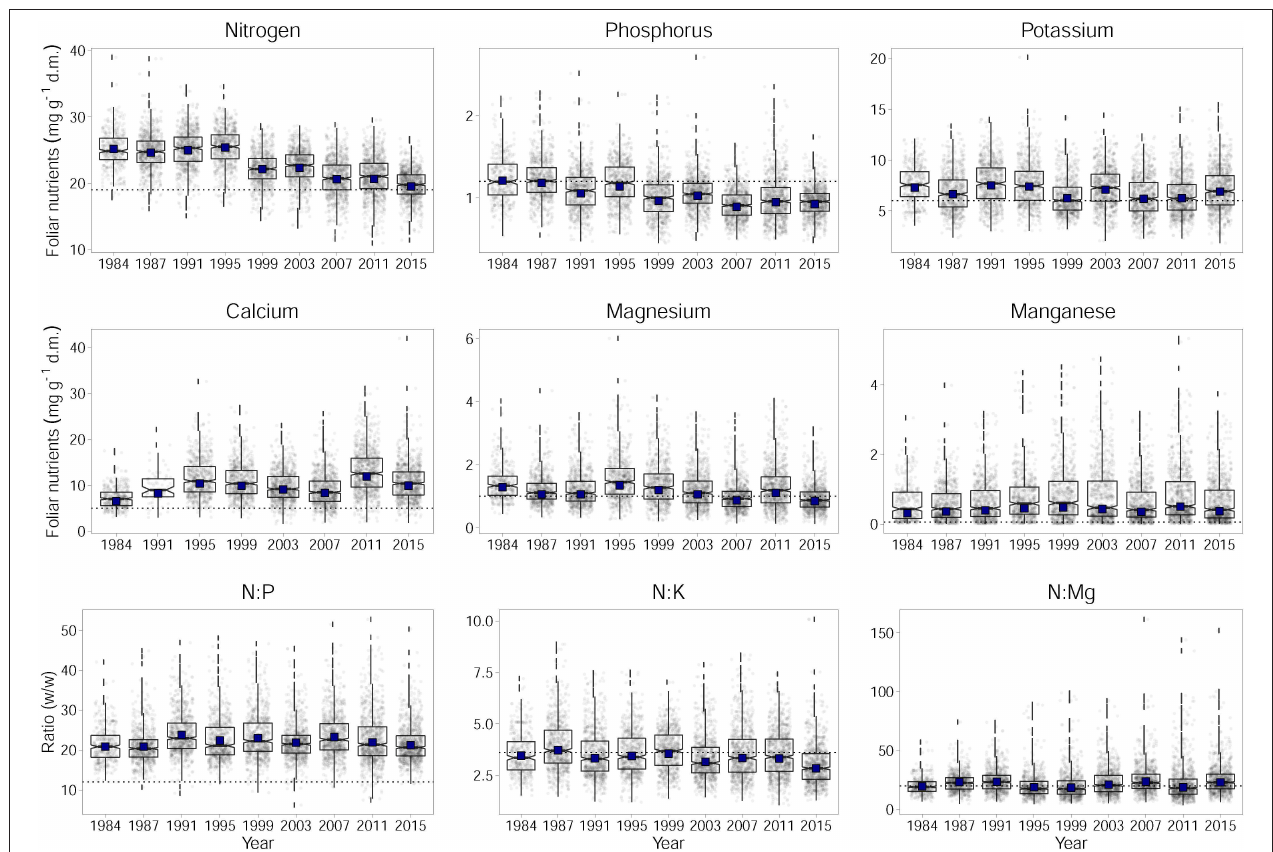
FIGURE 1 | Development of foliar nutrient concentrations of N, P, K, Ca, Mg, and Mn for Fagus sylvatica per dry matter (d.m.) and the ratios of N to P, K, and Mg. Horizontal dashed lines indicates lower limits of normal ranges according to Göttlein (2015) and the upper limits of normal ranges for the ratios according to Flückiger and Braun (2003) . Adjusted annual levels for the annually changing set of plots (by considering plot as a random effect) with year as fixed effect are given as black squares.